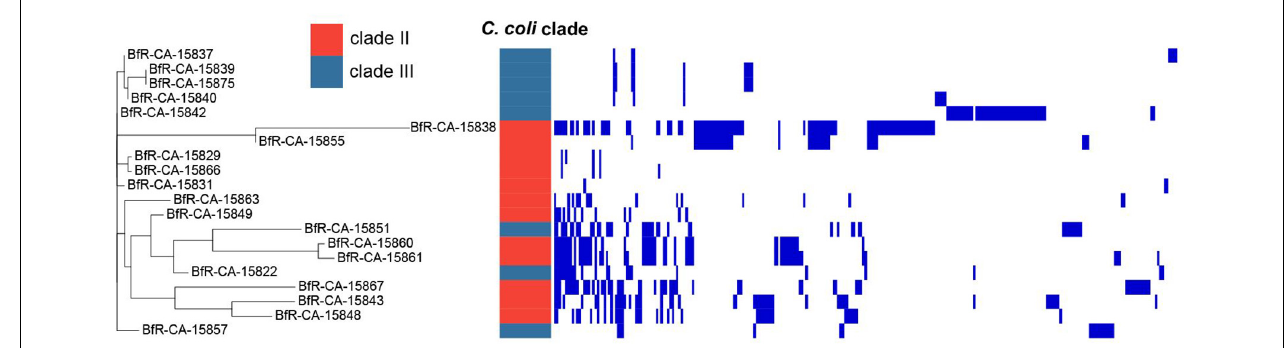
FIGURE 5 | Phylogenetic tree of plasmid-located genes of wild bird isolates based on presence or absence. Strains are depicted on the left. Blue bars indicate presence of plasmid-located genes ( Supplementary Table 4